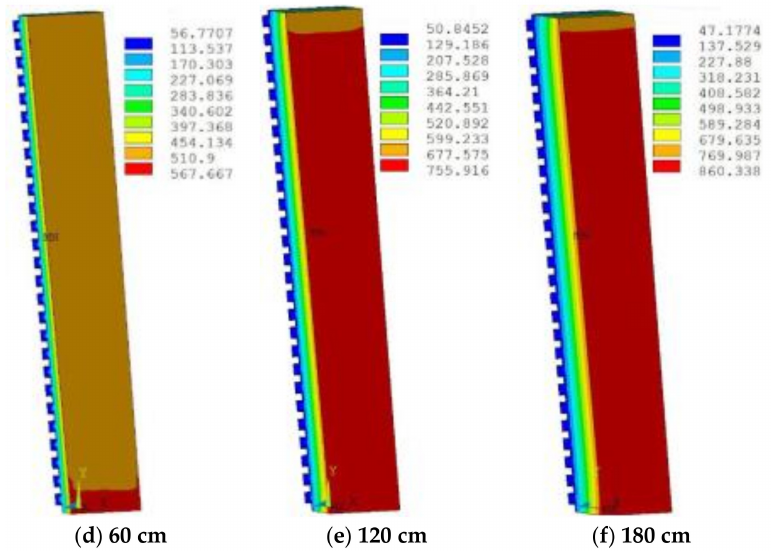
Figure 12. Temperature ( ◦ C) distribution of refractory bricks under different thicknesses.